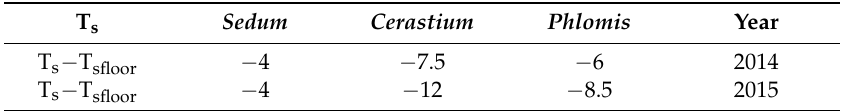
Table 6. Surface thermal gradients between the surface temperature of the plant species (T s ) and the paved surface temperature (T sfloor ), 19 November 2014 and 17 February 2015.